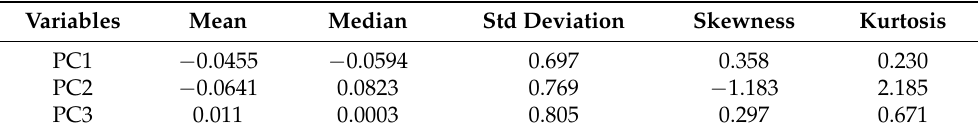
Table 1. Basic statistics of the